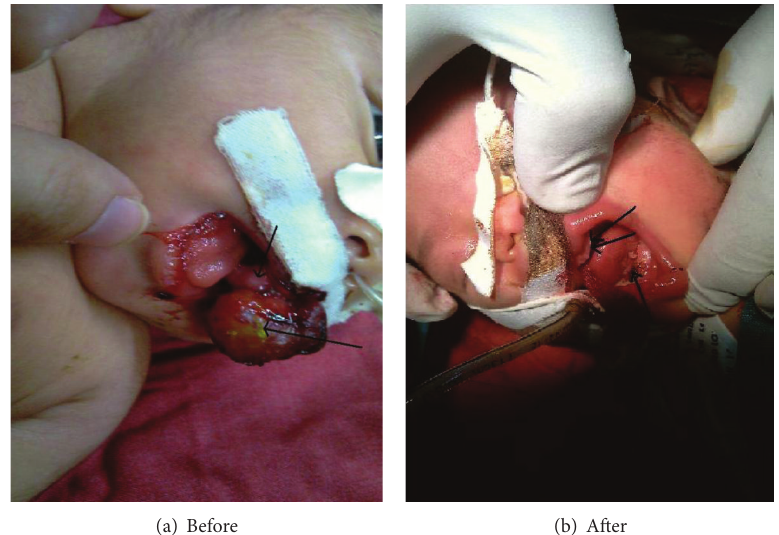
Figure 1: A large pedunculated mass and two other smaller tumors on the maxillary and mandibular alveolar ridges in a neonate female (before and after resection).